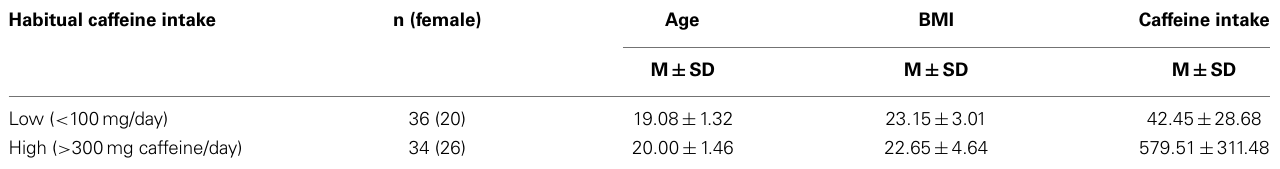
Table 1 |Age, gender, BMI, and caffeine intake distribution for study subjects. Habitual caffeine